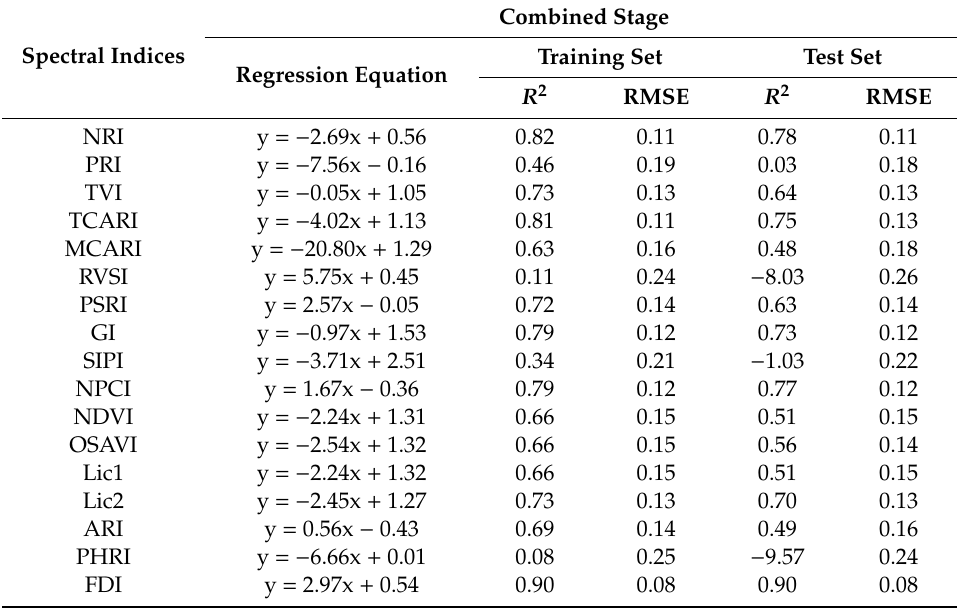
Table 4. Comparison of FDI and traditional spectral indices at the combined